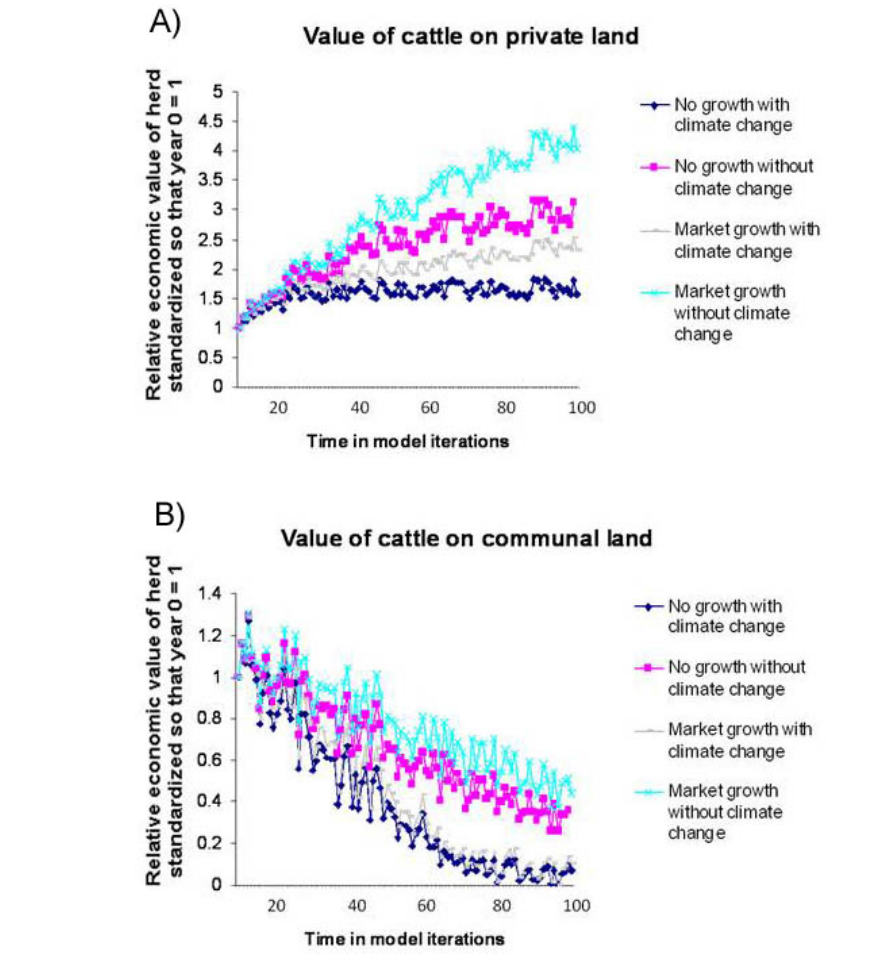
Fig. 6 . Market scenario options and their impacts on the value of cattle on A) private land and B) communal land across Southern Botswana (as per scenario assumptions in Table